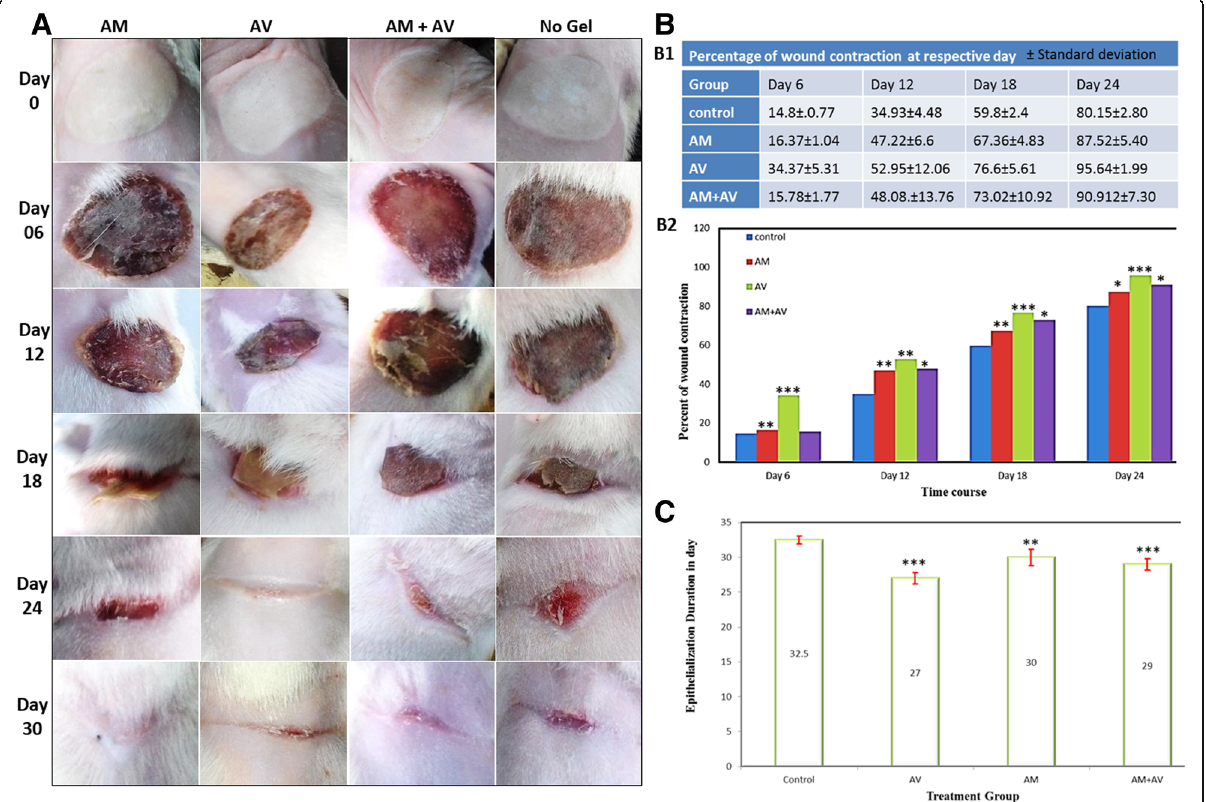
Fig. 5 Evaluation of wound closure, measurement of wound contraction and re-epithelialization. a Macroscopic wound healing images of Wistar rats at day 0, 6, 12, 18, 24 and 30 which were treated with AM, AV, AM+AV gel or without any gel (control). b Clinical evaluation of wound healing regarding wound contraction in rats at day 6, 12, 18, 24 (b1) and (b2) (level of significant was set * P < 0.05, ** P < 0.01 and *** P < 0.001 ). c Epithelialization period in different groups (*P < 0.05, ** P < 0.01 and *** P < 0.001